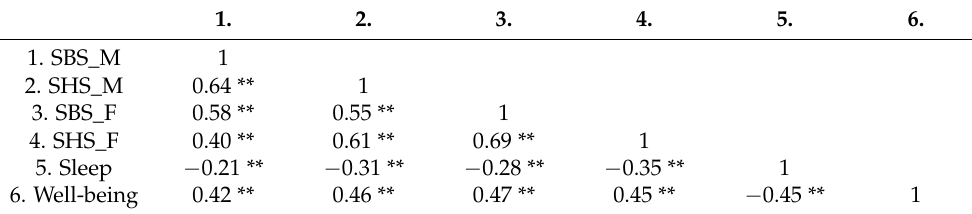
Table 2. Partial correlations between attachment dimensions, sleep, and well-being.